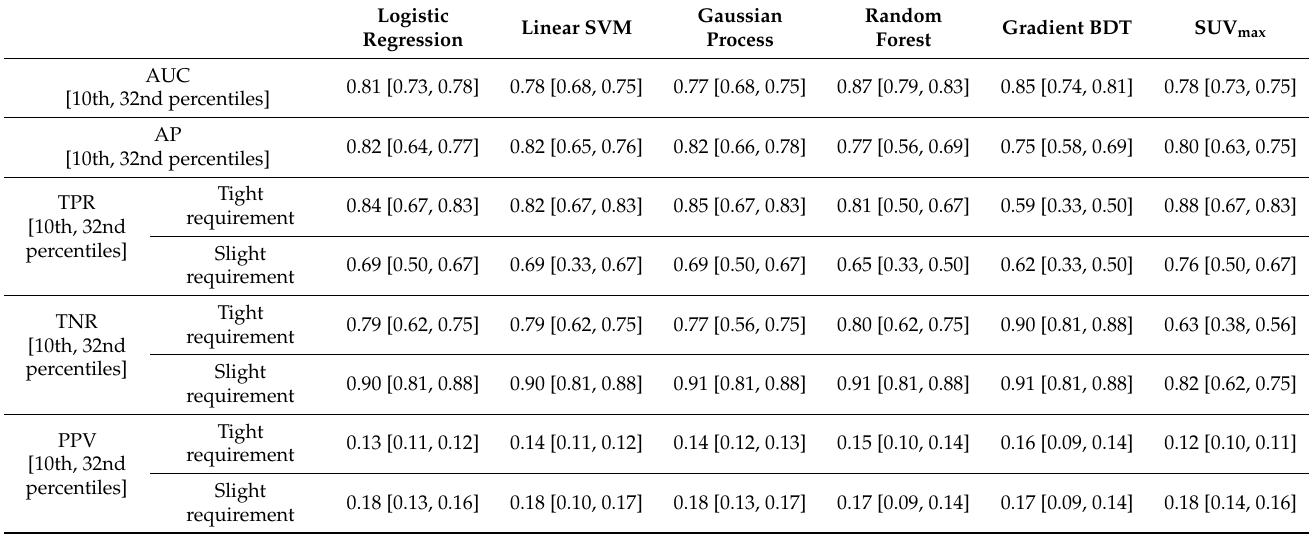
Table 3. Performance of different machine learning models and the SUVmax-based classifier in separating PMBCL and cHL lymphomas. TPR, TNR and PPV scores are reported for two user-defined decision thresholds, indicated in the table as tight/slight requirements and obtained requiring a sensitivity score greater than 0.9/0.7 on the training set.